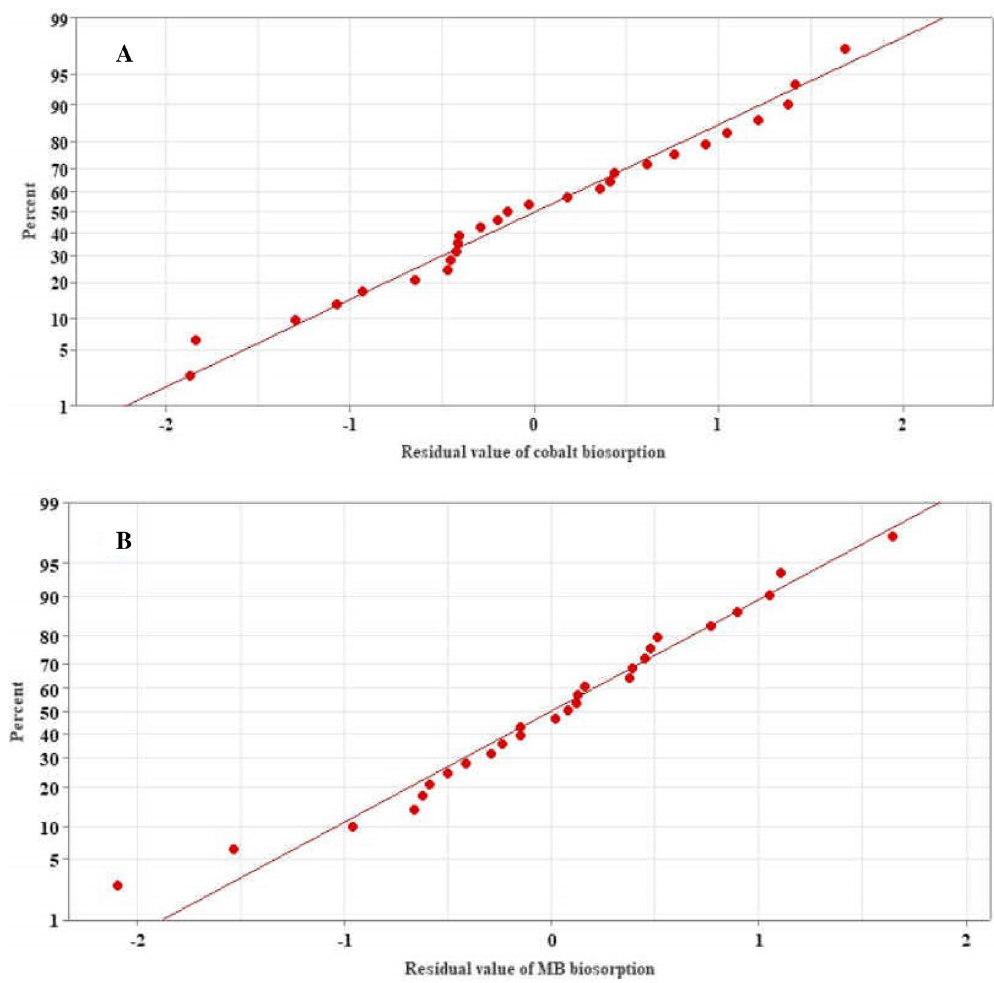
Figure 1. Normal probability plot of residuals of cobalt biosorption ( A ) and MB biosorption ( B ) by the biomass of Sargassum latifolium